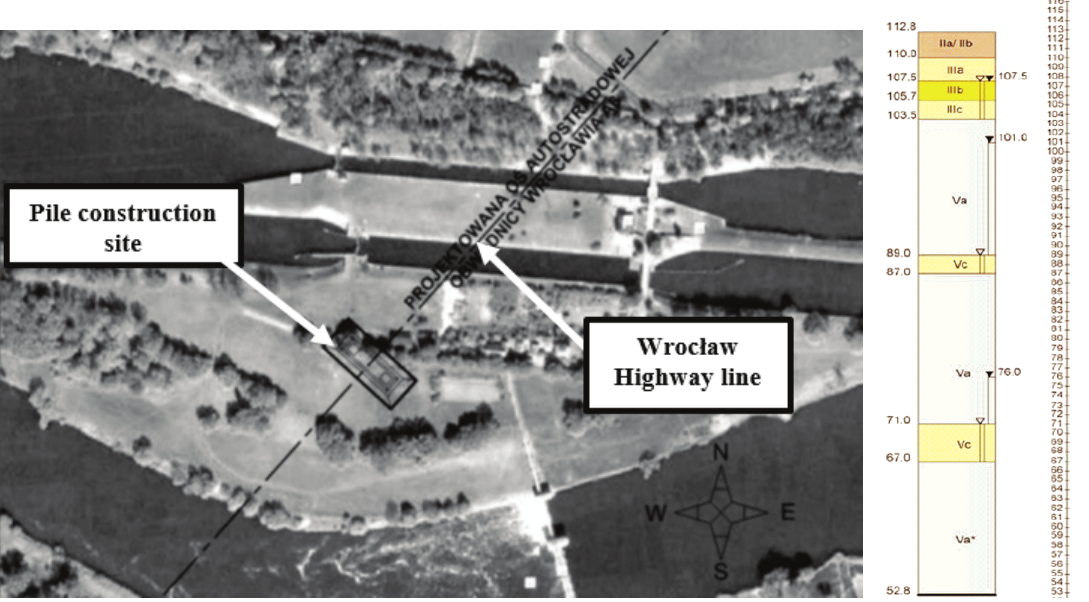
Fig. 2. Construction site and soil profile [2]